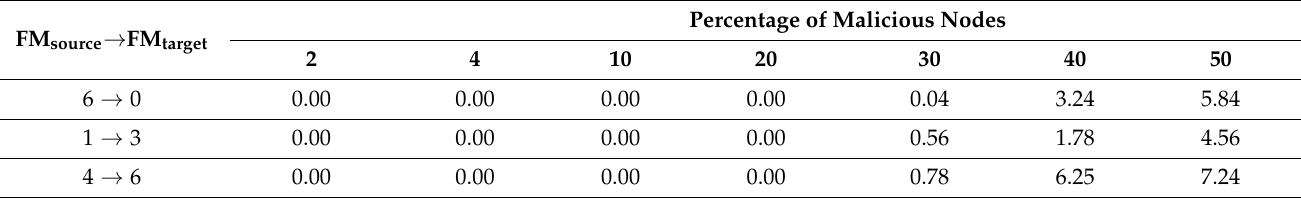
Table 3. Loss in source → target with different counts for the Fashion-MNIST dataset under Blockchain-Enabled